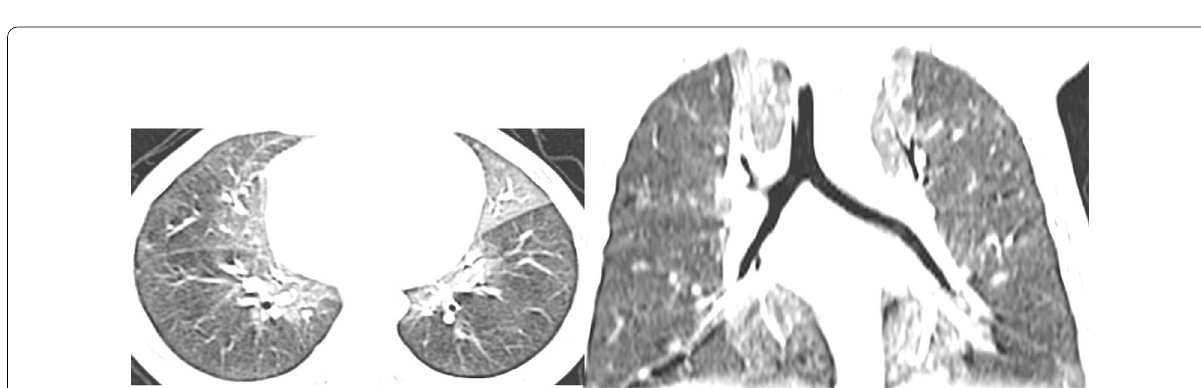
Fig. 5 A 1.5-year-old male with dyspnea and persistent oxygen requirement since birth, diagnosed with NEHI. Axial and coronal CT lung windows showed bilateral homogenous ground-glass densities mainly involving the medial lung fields with a well-defined lateral margin and a CT score of